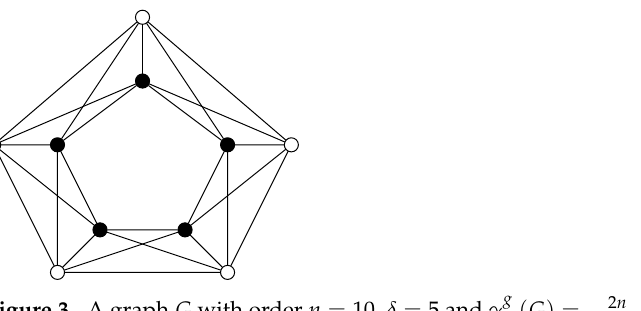
Figure 3. A graph G with order n = 10, δ = 5 and γ g